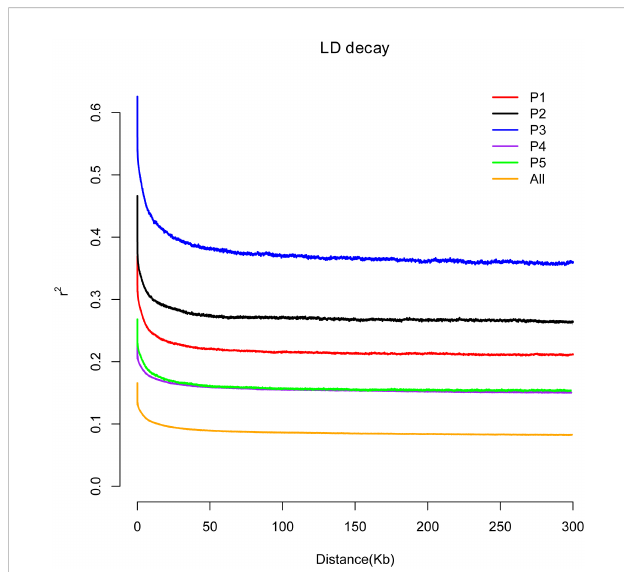
FIGURE 4 Decay of linkage disequilibrium of the rootstocks of different grape varieties. The abscissa represents the distance of linkage disequilibrium (LD), and the ordinate is the correlation coef fi cient of linkage